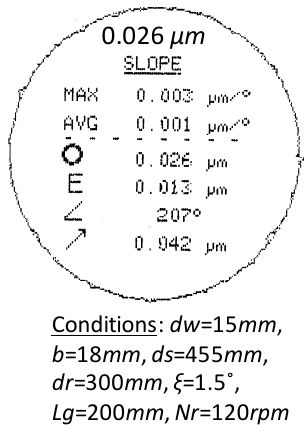
Figure 10. RSI vs. roundness (simulation).